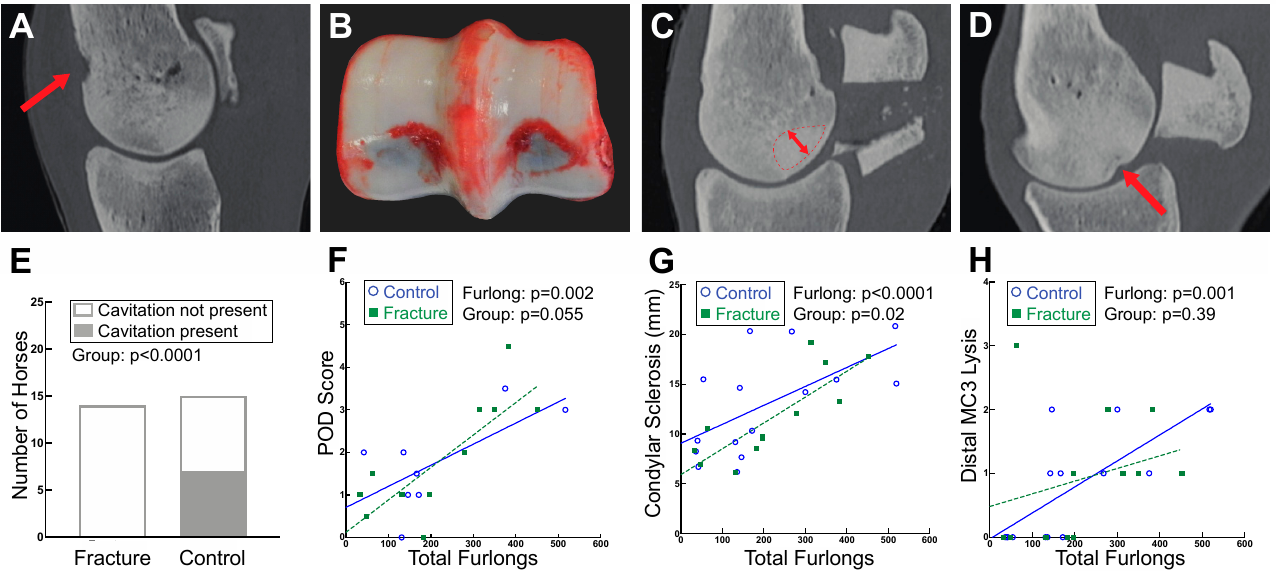
Figure 2. Evidence of palmar osteochondral disease (POD) was found on both gross pathology and CT analysis of the distal MC3. ( A ) Sagittal plane CT image of a control case with dorsal cavitation (indicated by the red arrow) of MC3 at the level of the proximal MCPJ. ( B ) Gross photograph of a fracture case with grade 3 POD of MC3. ( C ) Sagittal plane CT image demonstrating the region analyzed for condylar sclerosis measurements (dashed line with arrow indicating depth measured). ( D ) Sagittal plane CT image depicting distal MC3 subchondral lysis (indicated by red arrow). ( E ) Dorsal cavitation of MC3 at the level of the proximal MCPJ was identified in 7 out of 15 control horses but was not present in any of the fracture horses. ( F ) Gross POD scores increased with greater total furlongs. ( G ) The area of condylar sclerosis was larger in horses with greater total furlongs. ( H ) Distal MC3 lysis scores were higher in horses with greater total furlongs.